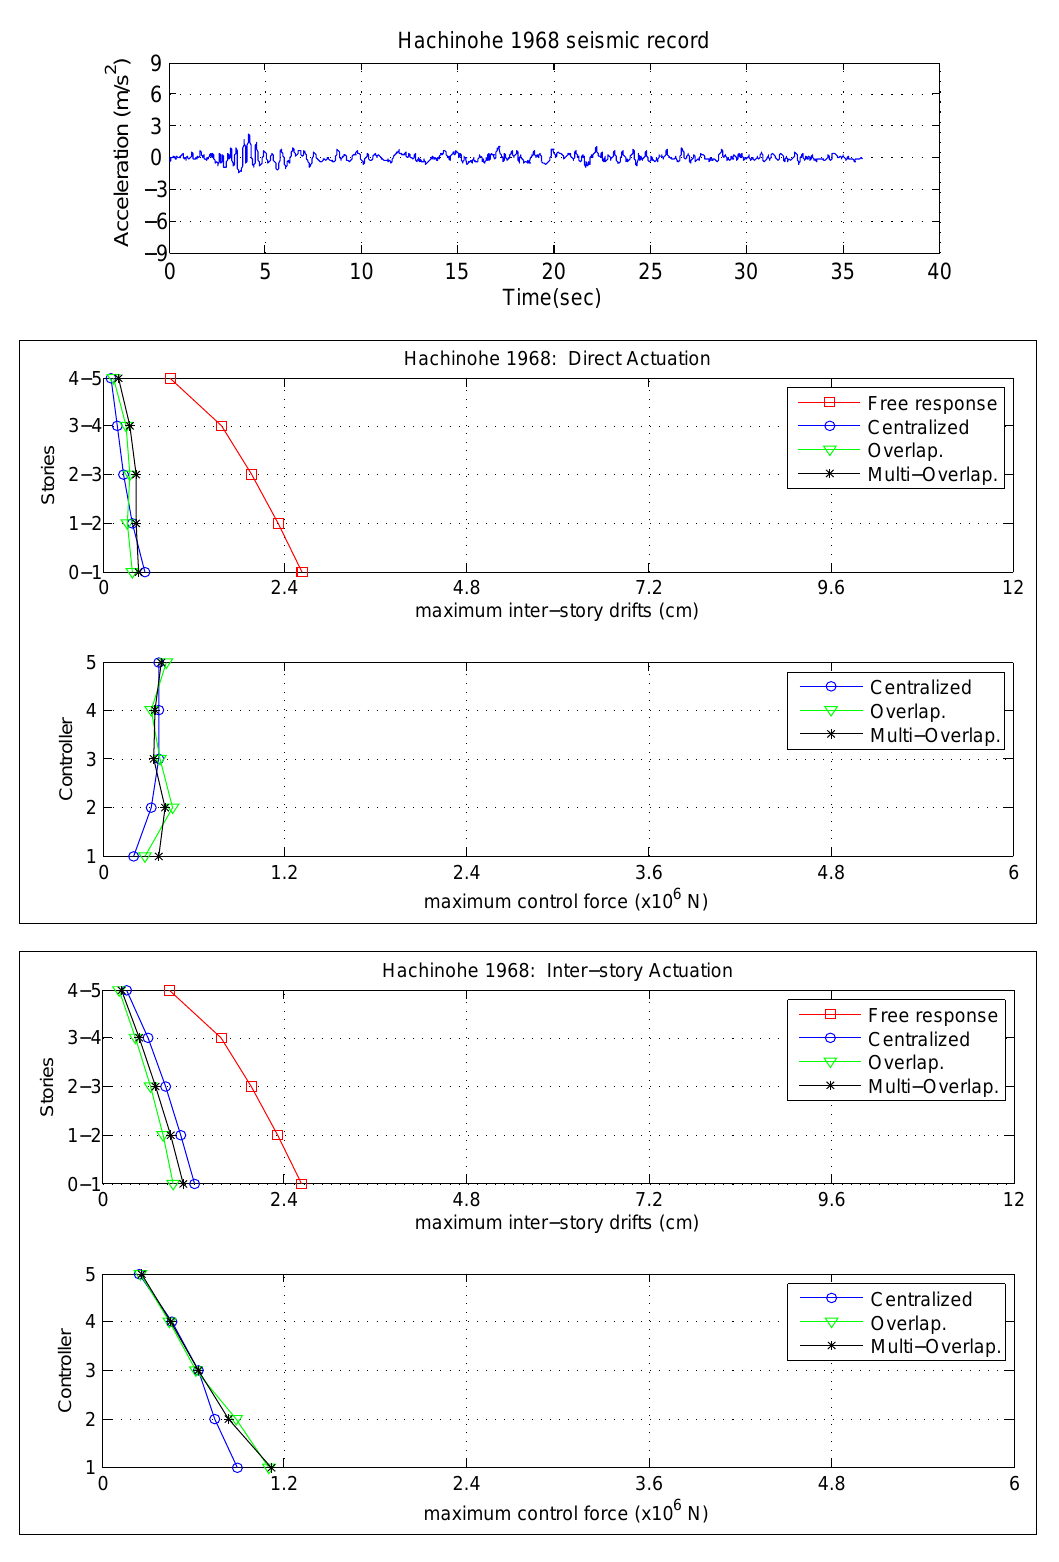
Figure 10: Hachinohe 1968 seismic record. Maximum inter-story drifts and control